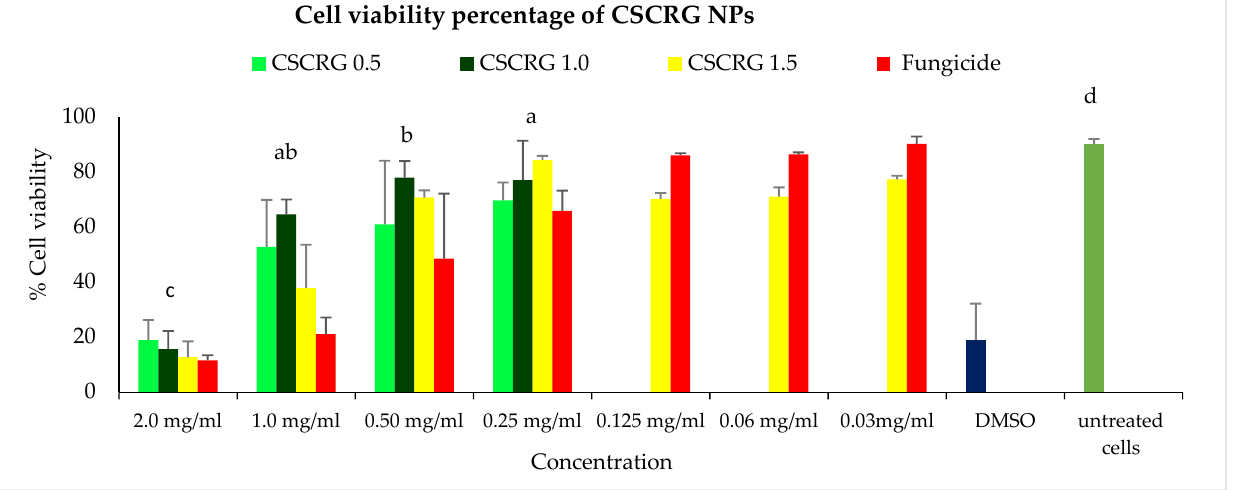
Figure 10. Toxicity of CSCRG NPs in the form of percentage cell viability in Vero cell lines. Caps on bars represent standard deviation. Different letters in graph columns show significance levels at p ≤ 0.05 according to a Bonferroni post hoc t -test.